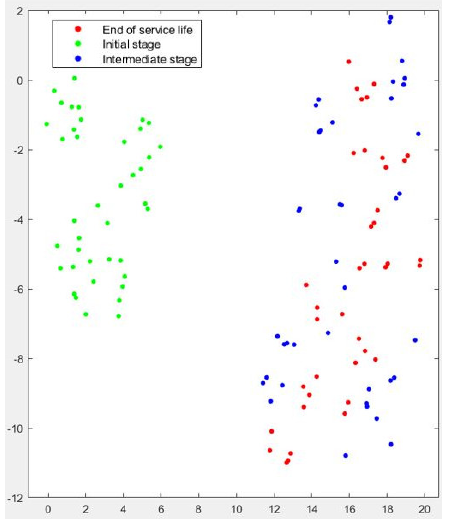
Figure 11. Graphical results of t-SNE dimensionality reduction for Test No.3.